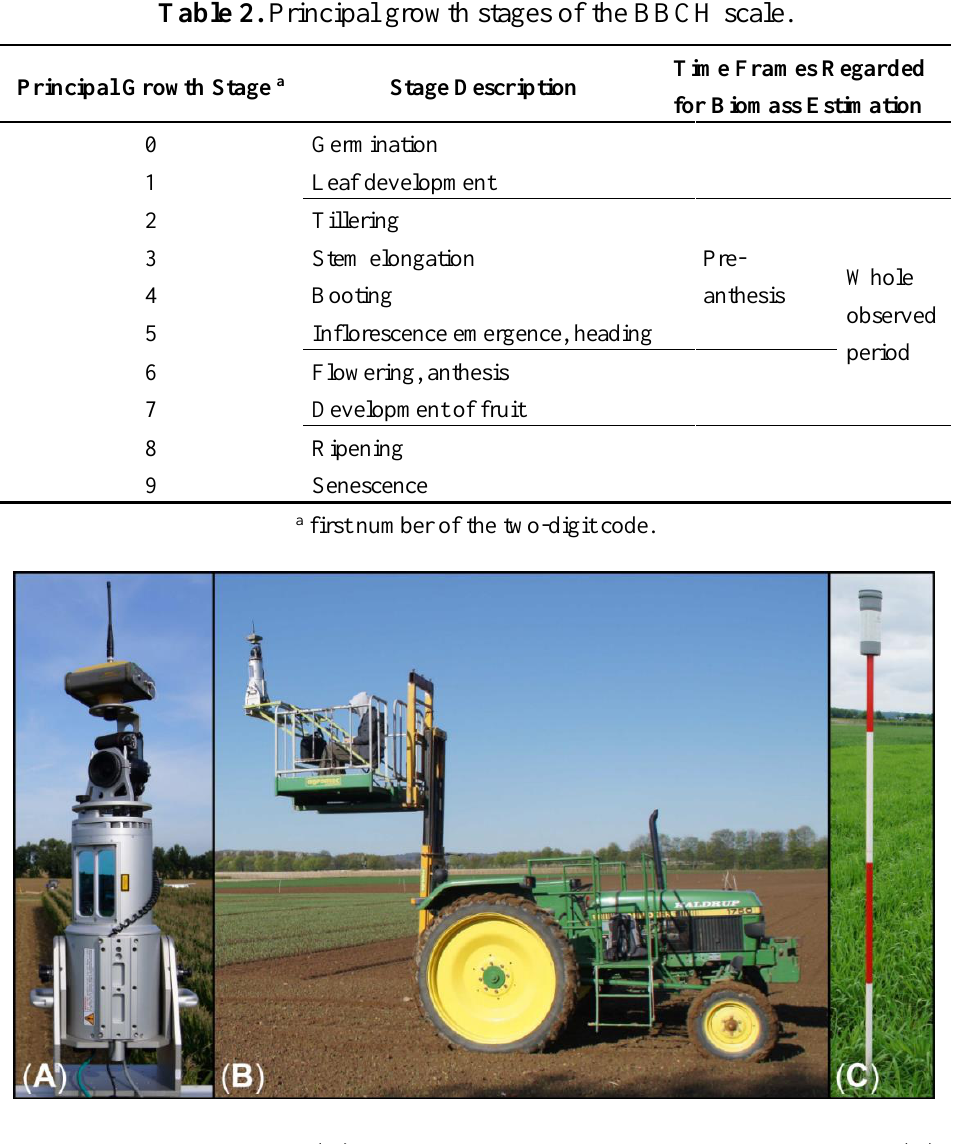
Figure 1. Instrumental set-up: ( A ) terrestrial laser scanner Riegl LMS-Z420i; ( B ) tractor with hydraulic platform; ( C ) ranging pole with reflective